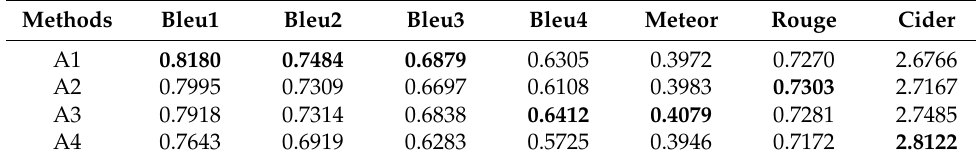
Table 4. Ablation performance of our designed model on the Sydney-Captions data set [33]. Methods